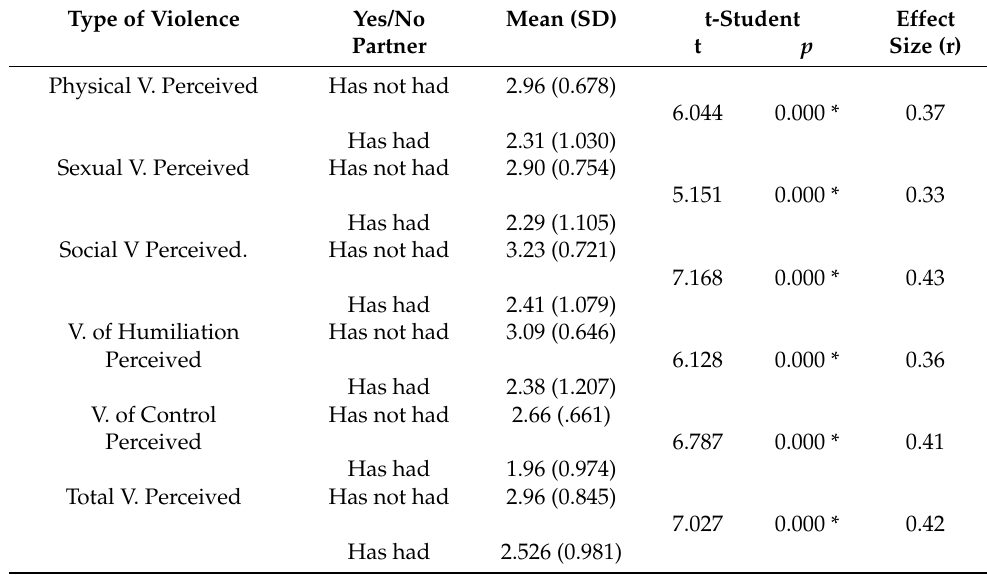
Table 6. Differences in Violence Perceived between people who have had a dating relationship and those who have